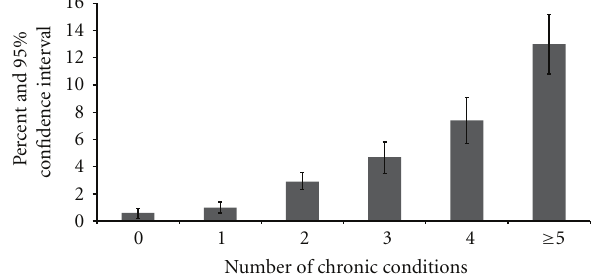
Figure 2: Environmental barriers among the top 5 most common chronic conditions.